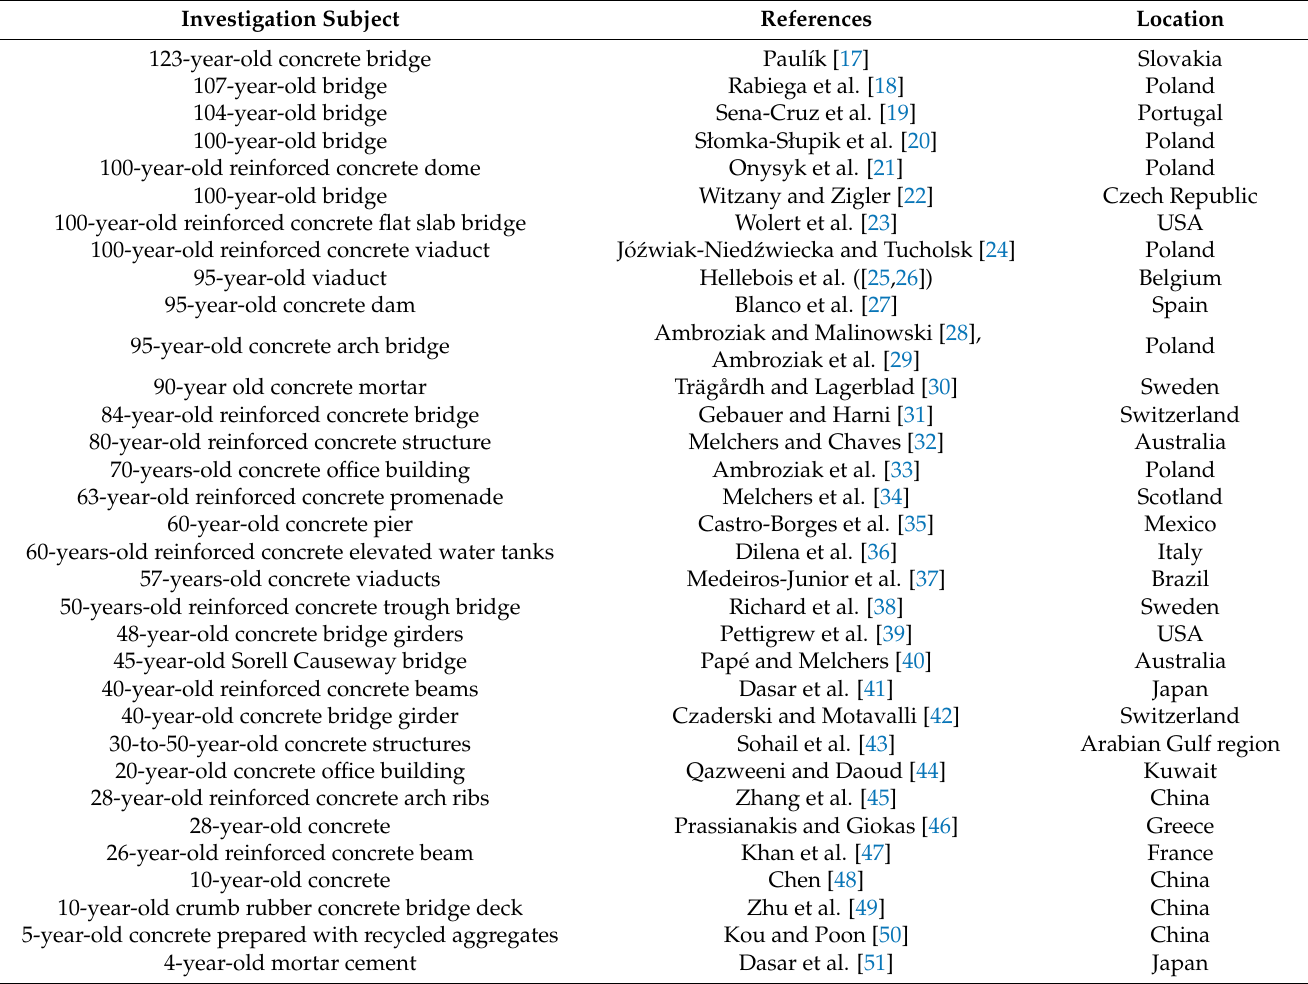
Table 1. References of investigations into the chosen old concrete